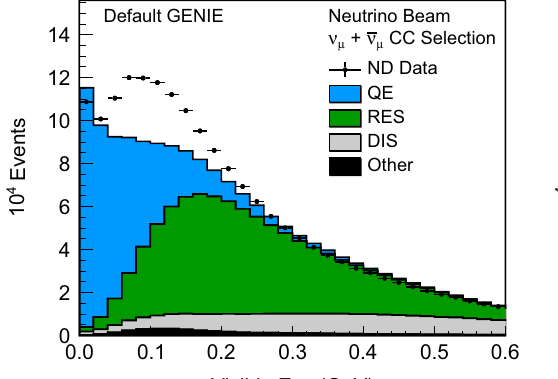
by black points with statistical error bars; the stacked histogram is the sum of the GENIE predictions for the the various interaction